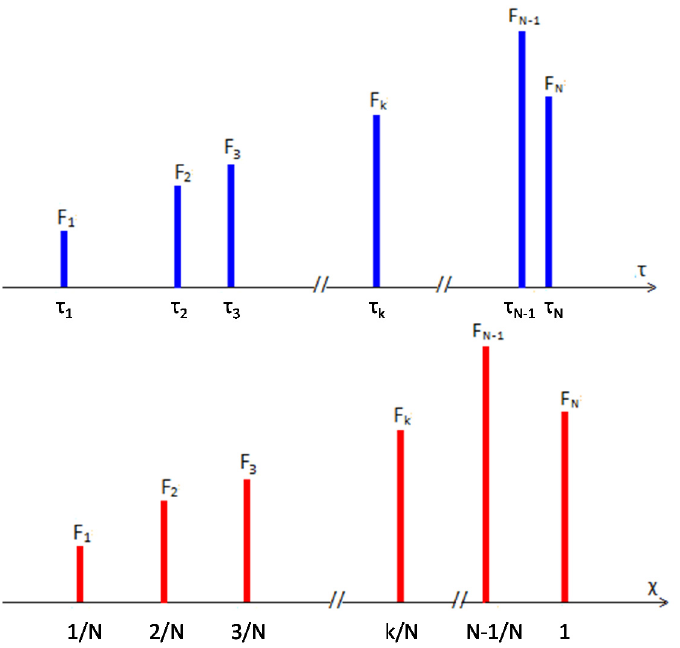
Figure 1. Schematic interpretation of the F- function in terms of conventional time ( up ) and in the Natural Time domain ( down ).